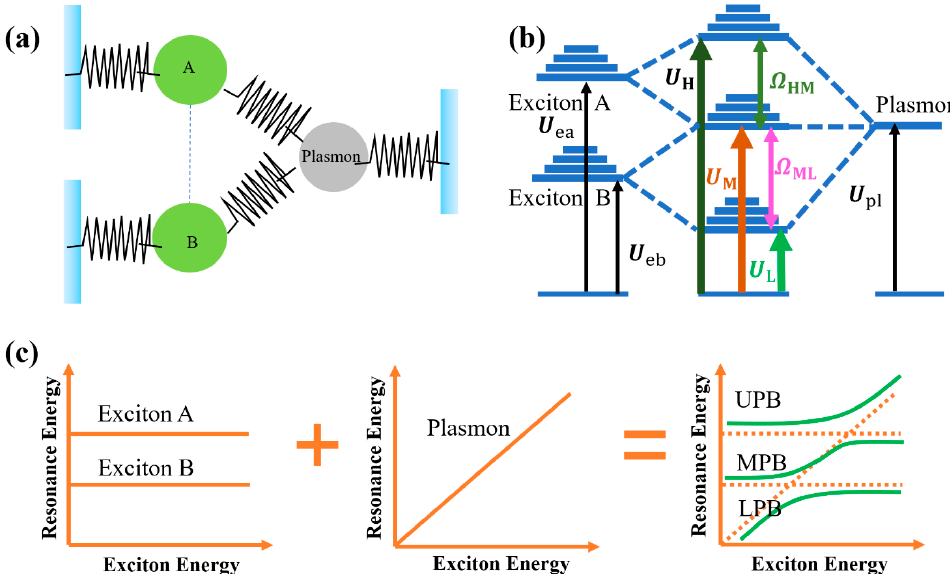
Figure 2. ( a ) Schematic diagram of the three-coupled oscillator model. ( b ) Schematic diagram of plasmon and exciton multimode coupling energy level splitting. Adapted with permission from Ref. [92]. Copyright 2019 American Chemical Society. ( c ) Double anticrossing dispersion curves of plasmon–exciton multimode coupling.